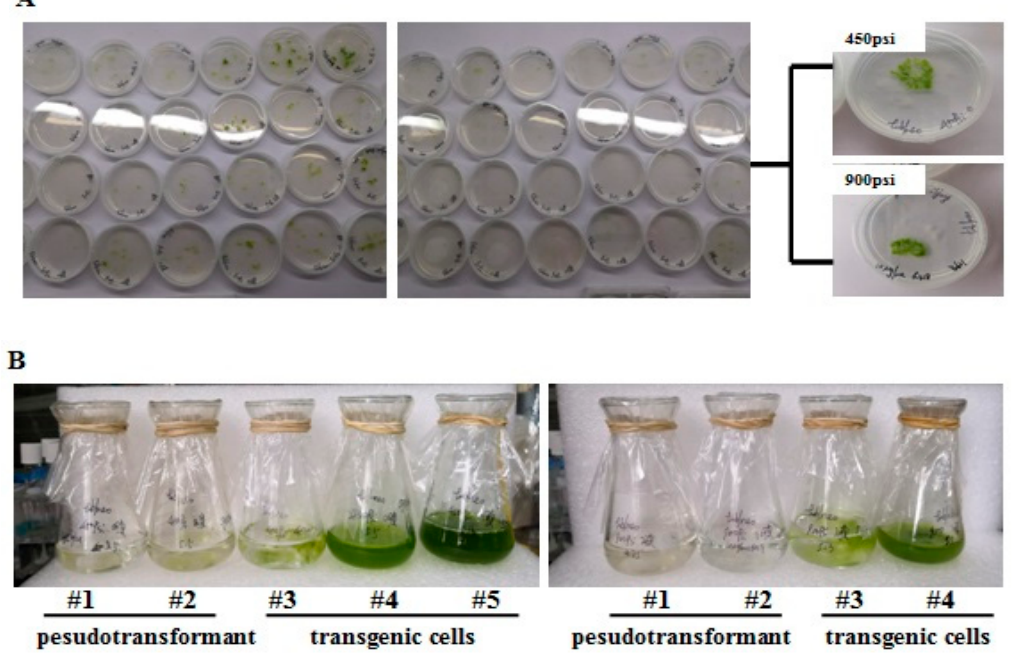
Figure 3. Agar and liquid selecting of transgenic cells. ( A ) Cells grown on an agar plate containing 10 µ g mL − 1 G418. ( B ) After growth, cells were transferred from the agar plate to BG11 medium supplemented with 20 µ g mL − 1 G418.